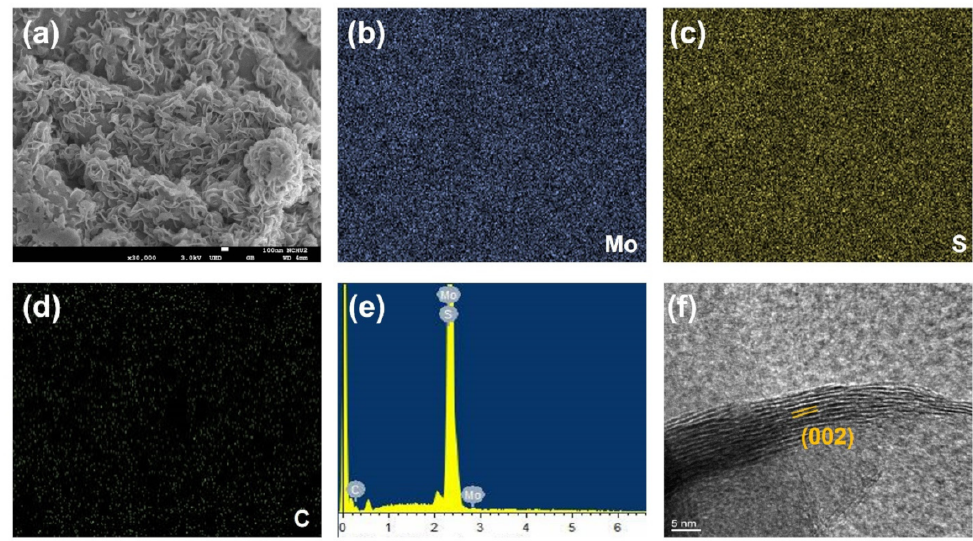
Figure 2. ( a ) SEM image, ( b – d ) elemental mapping; ( e ) EDX spectrum. and ( f ) HR-TEM image of 1T-MoS 2